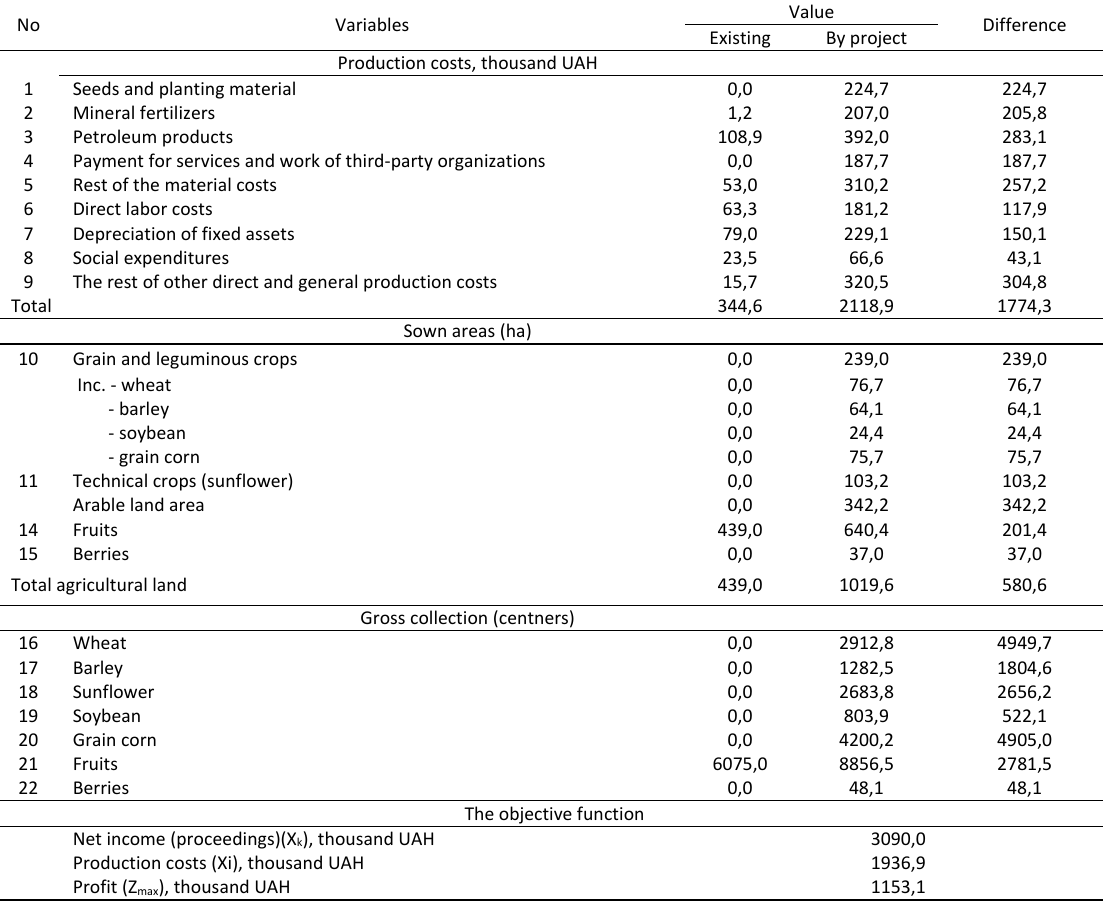
Table 3: The results of optimization modeling of sectoral structure in researched agricultural enterprise No Variables